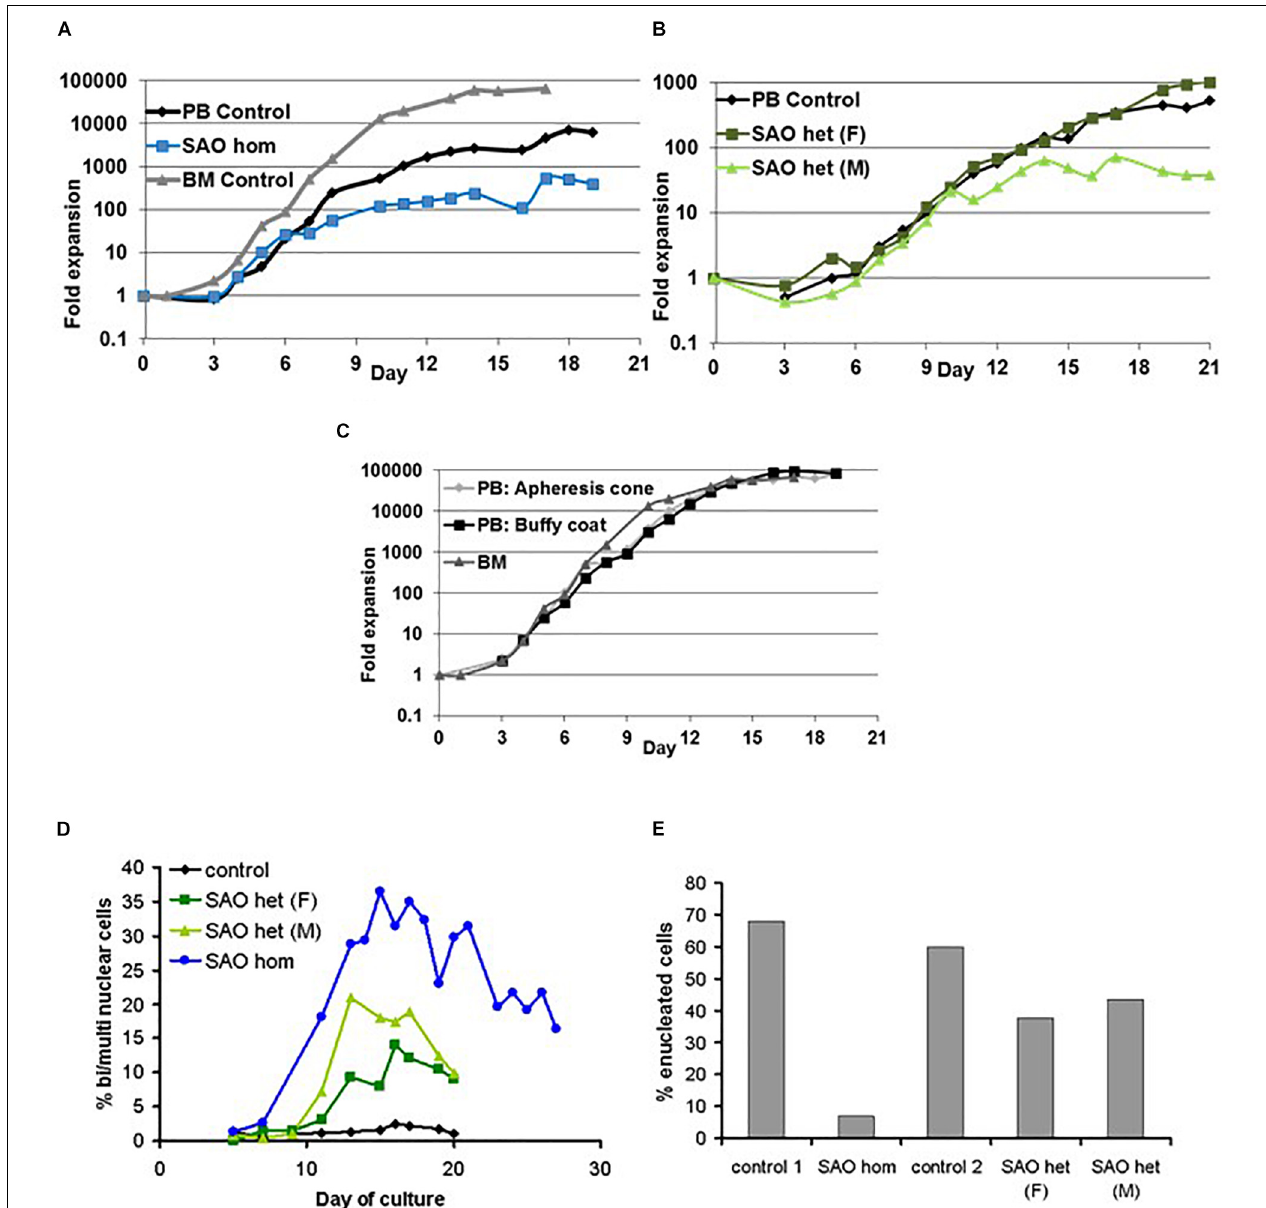
FIGURE 4 | Proliferation of cultured CD34 + cells. Control, heterozygous SAO and homozygous SAO CD34 + cells were cultured, and their fold-increase in cell number is shown, plotted against the day of culture. (A) Expansion of homozygous SAO (blue line) and control (black line) CD34 + cells in culture. The SAO CD34 + cells were isolated from 3 ml of bone marrow (BM), the control CD34 + cells from peripheral blood (PB; 50 ml). A further control CD34 + culture grown from frozen BM CD34 + cells, but at a different time and therefore not directly comparable, is shown (gray line). (B) Expansion of heterozygous SAO (SAO [father (F) dark green line]; SAO [mother (M) pale green line]) and control (black line) CD34 + cells in culture. All three cultures were grown from CD34 + cells isolated from peripheral blood (PB; 50 ml). (C) Comparison of the typical rate of expansion of three controls where the CD34 + cells were isolated from different sources. Expansion of adult derived CD34 + cells in culture from a fresh apheresis cone (pale gray line), fresh buffy coat (black line) or from frozen bone marrow (gray line). (D) Graph showing the percentage of cells with two or more nuclei over the course of the cultures. Cells were counted from cytomicrographs, and counts were averaged from 3 different fields. Numbers of cells counted per field were 125 ± 48 (s.d.). (E) Graph showing the percentage of cells that had successfully enucleated at day 20 in culture. Cells were counted from cytomicrographs, and counts were averaged from 5 different fields. Numbers of cells counted per field were 136 ± 45